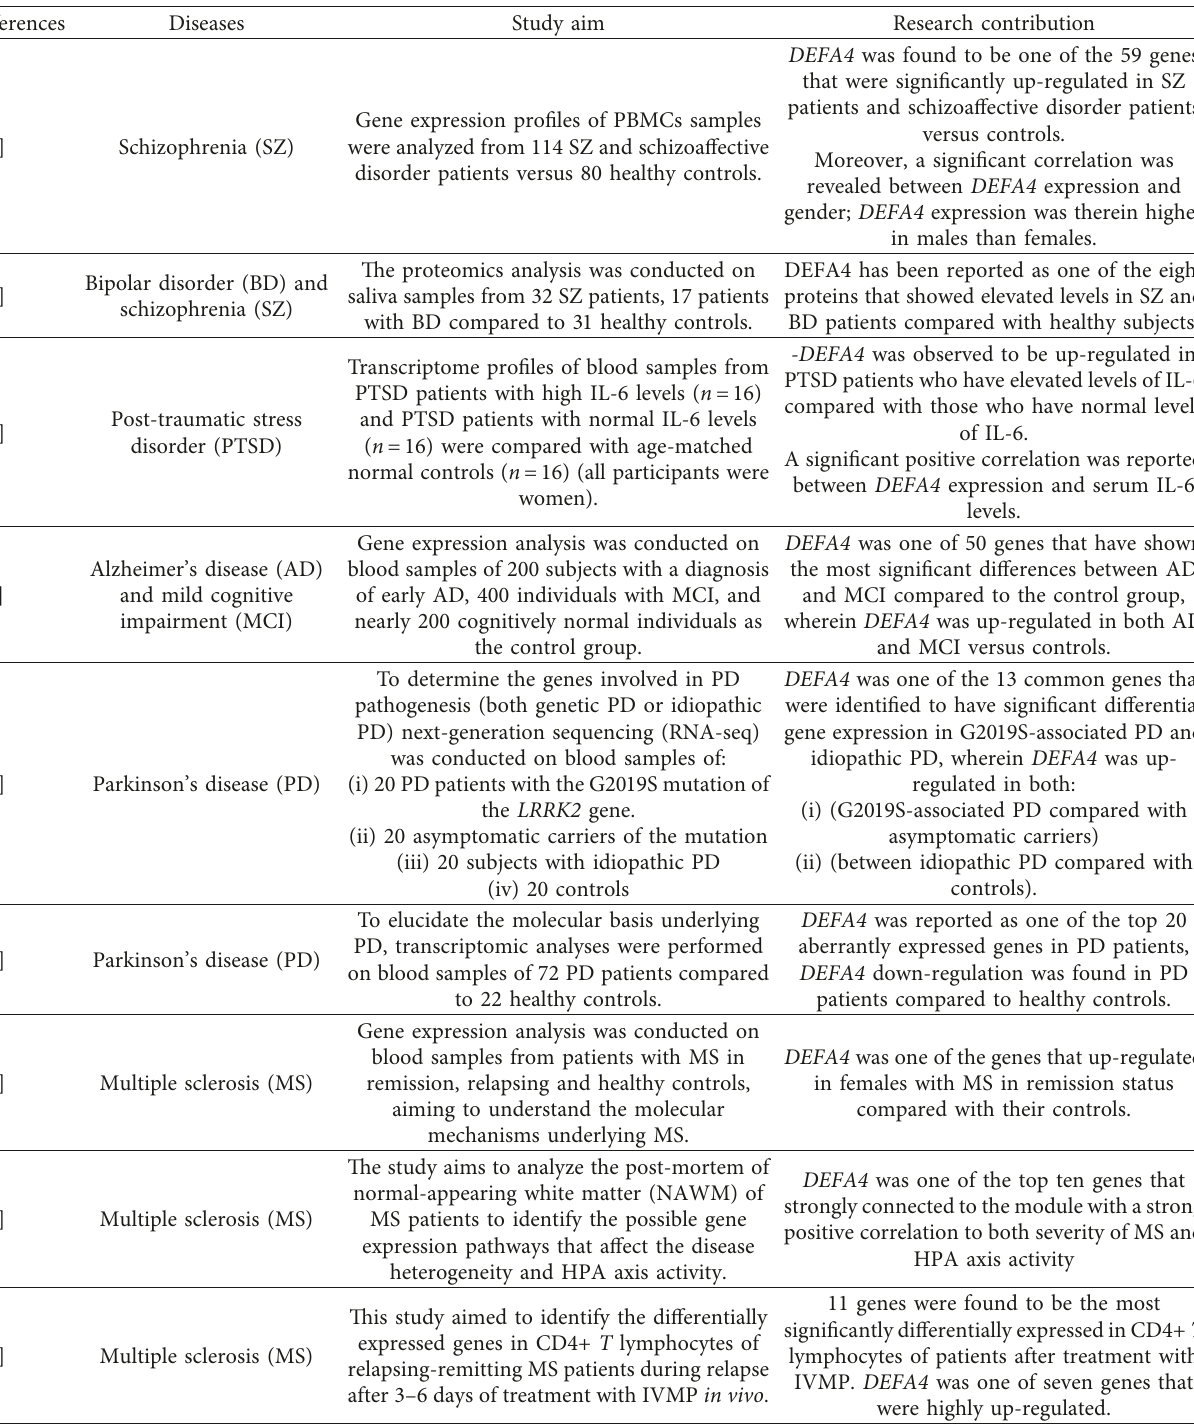
Table 2: A list of studies reporting DEFA4 gene expression changes in nervous system-related